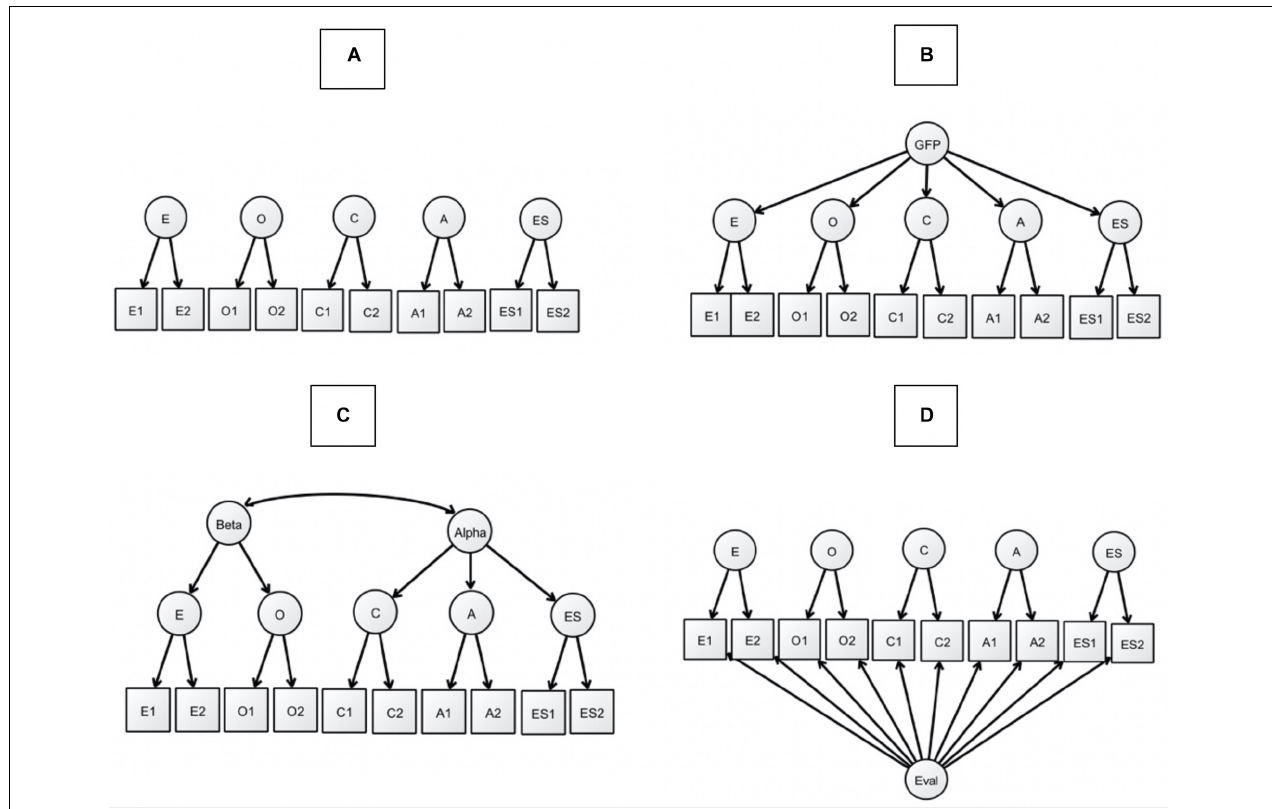
FIGURE 1 | The four types of models tested in study 2. Panel (A) has the standard FFM model, panel (B) the GFP model, panel (C) the alpha beta model and panel (D) the bi-factorial evaluative model. The number of observed variables is lower than in the tested